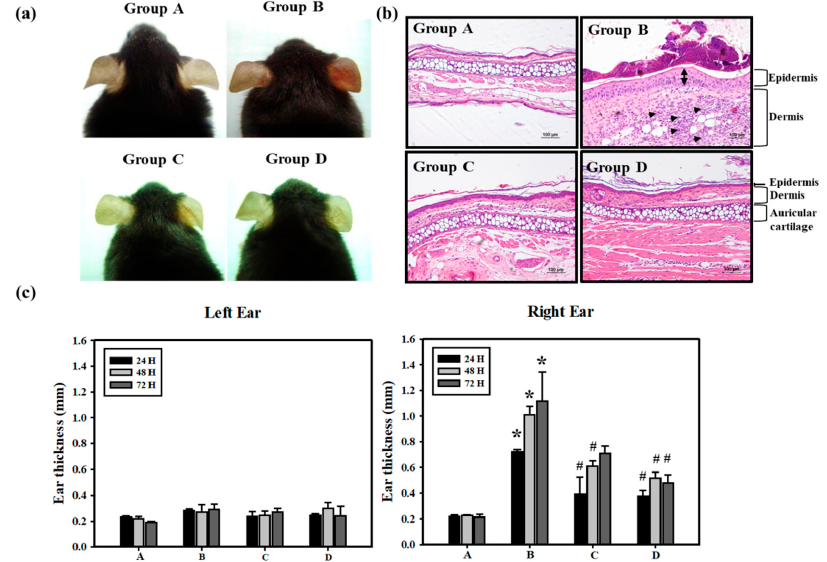
Figure 2. Protective effects of PT on Cr(VI)-induced ACD mice. ( a ) Swelling and erythema were documented by photography at 48 h. ( b ) H&E histology of mice ear skin after the elicitation test with Cr(VI) showed ear swelling and inflammatory cell infiltration at 72 h. In the dermis, the increased number of inflammatory cells, neutrophils, was observed (arrowhead) in K 2 Cr 2 O 7 treatment (Group B). In the epidermis, Group B showed the stratum corneum thickening (bi-arrowhead), but NAC (Group C) or PT (Group D) treatment significantly suppressed Cr(VI)-induced increases in ear thickness. Also, no differences in the auricular cartilage were observed (scale bar representing 100 µ M). ( c ) ACD reactions were quantified by measuring the ear thickness at 24, 48 and 72 h after the elicitation test ( n = 5). The time course measurement of Left (vehicle) and Right (epicutaneous) ear thickness. (A: Control; B: K 2 Cr 2 O 7 ; C: NAC; D: PT) (* p <0.05 versus control group; # p <0.05 versus K 2 Cr 2 O 7 group).